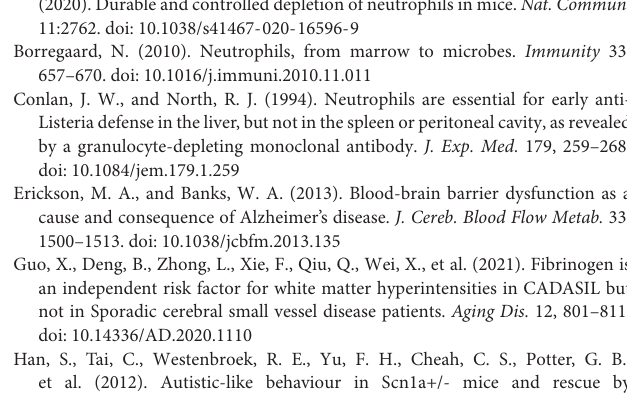
Supplementary Figure 1 | Anti-Gr-1 antibody did not change the density of microglia. (A) Representative immunohistochemistry images of TMEM119-positive cells (microglia marker) of hippocampal CA1 section showed anti-Gr-1 treatment did not affect the density of microglia. Scale bar: 50 µ m. (B) Quantification of the mean integral optical density of TMEM119-positive microglia. P = 0.6827. Data are expressed as means ± SE ( n = 3 per group). ∗ P < 0.05 compared with that of the control